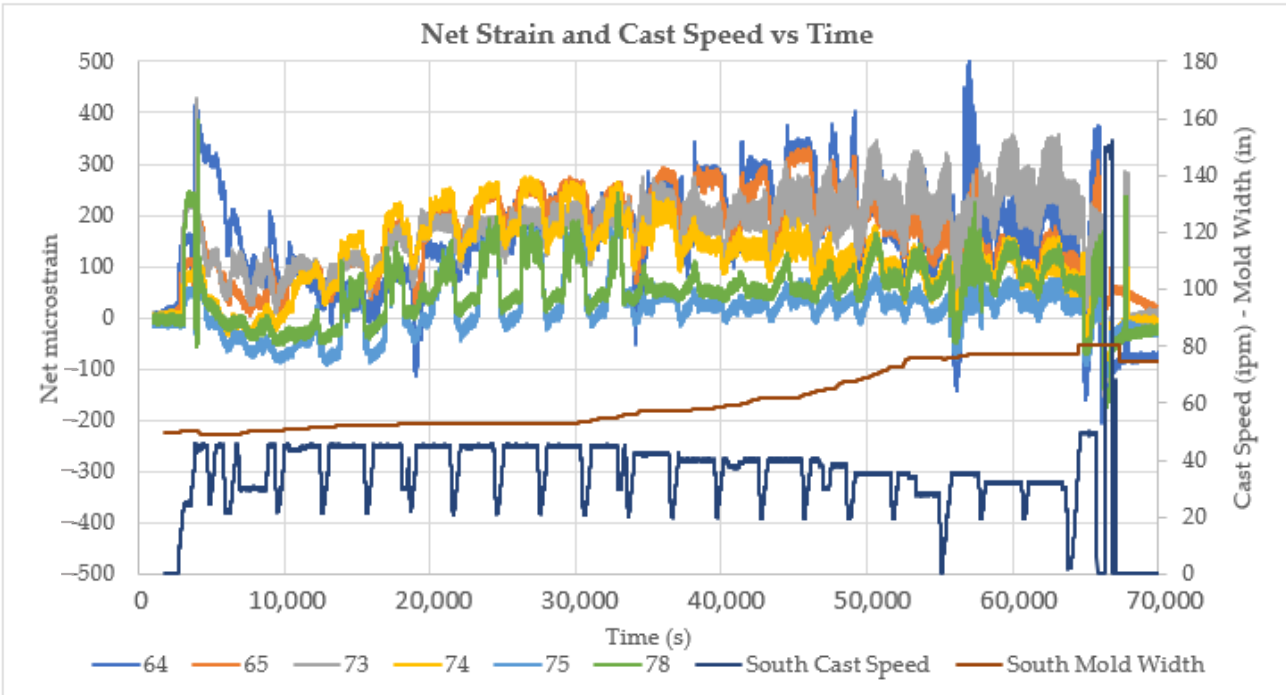
Figure 18. Net strain at all roll locations superimposed on casting speed and slab width data for a 20-heat cast sequence over approximately 14 h of caster operation.